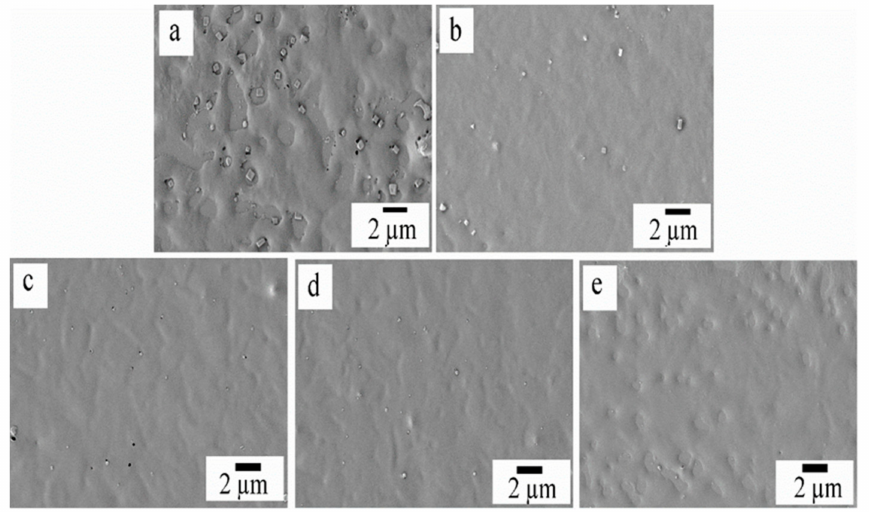
Figure 3. SEM micrographs of ( a ) CO 0% –WPU, ( b ) CO 2.50% –WPU, ( c ) CO 5.04% –WPU, ( d ) CO 7.40% – WPU and ( e ) CO 9.66% –WPU.